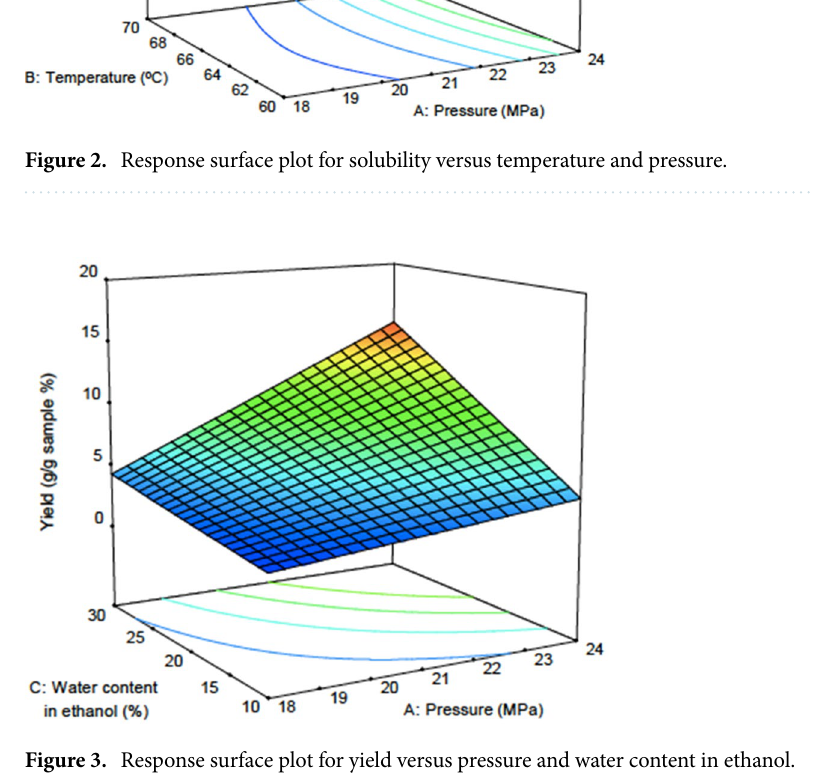
Figure 3. Response surface plot for yield versus pressure and water content in